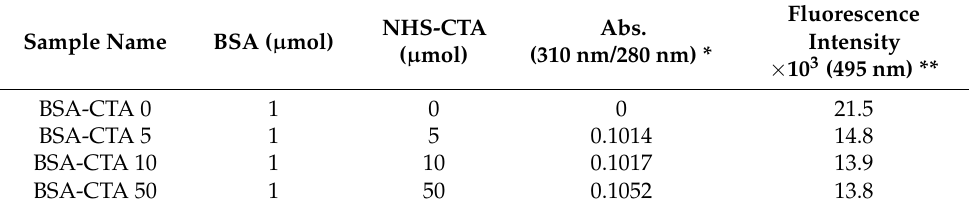
Figure 2. ( Left ) UV absorbance of BSA-CTA with different feeding ratios at 310 nm. The absorbance intensity was calculated by comparing thiocarbonyl group of CTA (310 nm) to BSA (280 nm) (red). ( Right ) Fluorescence intensity of fluorescamine at 495 nm conjugated with unreacted amino residues in BSA-CTA (blue). Table 1. Feeding ratios of